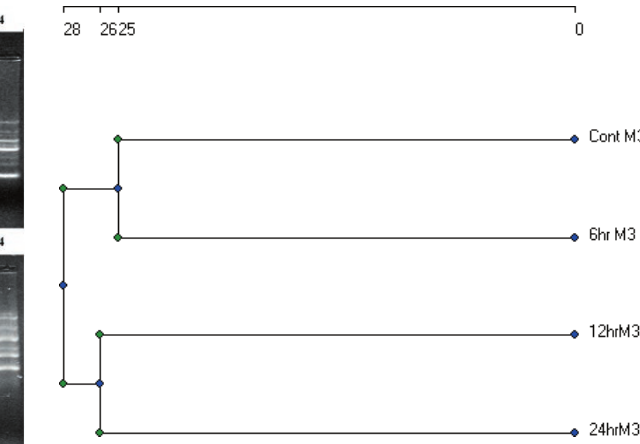
Figure 5. UPGMA based cluster tree of Vicia faba (Misr 3) culti- var exposed to 5 mM AlCl 3 for (0.0, 6, 12 and 24hr) based on (10 RAPD + 9 ISSR primers).